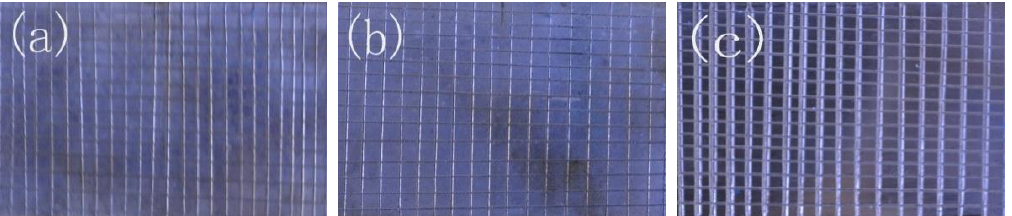
Figure 4. Adhesion property of copper film by cross-scratched method. ( a ) TES-SAMs modified; ( b ) MPTMS-SAMs modified; ( c ) APTES-SAMs modified.